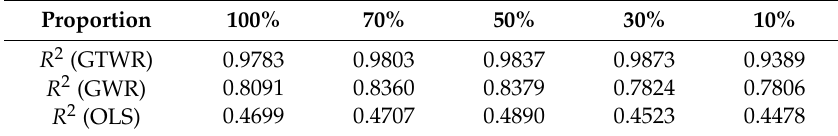
Table 6. GTWR model performance in comparison with different sample proportions.